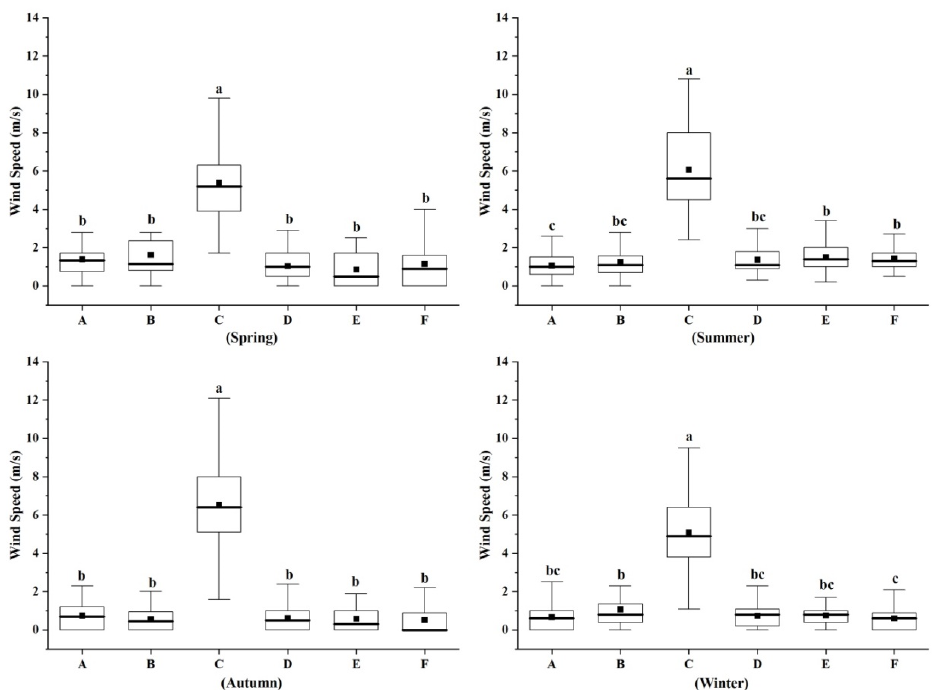
Figure 9. The wind speed changes of different forest types in different seasons. A— Phyllostachys edulis forest; B—Subtropical evergreen broad-leaved forest; C—Forestless control group; D— Liquidambar formosana forest; E— Cunninghamia lanceolata forest; F—Coniferous and broad-leaved mixed forest. The different lowercase letters indicate significant difference among the stand types in the same time ( p < 0.05).